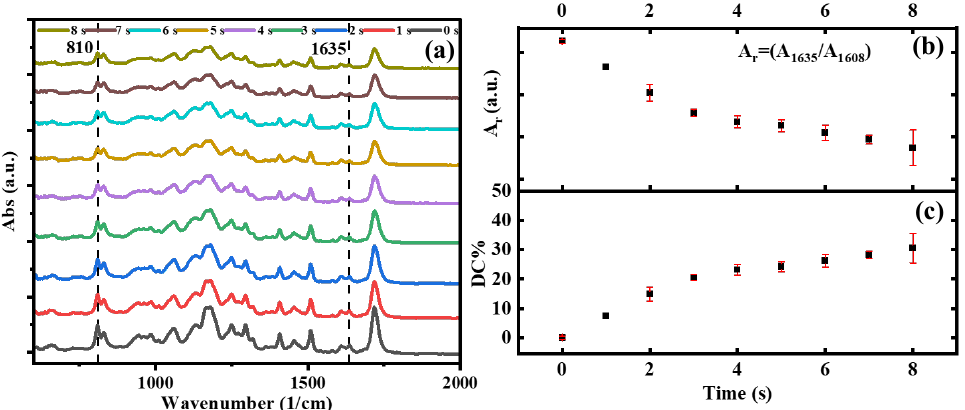
Figure 6. FTIR-ATR absorption spectra of freely polymerized layers and unpolymerized resin ( a ), relative absorbance ( b ), and degree of double bond conversion ( c ) of monolayer films polymerized at different exposure times without printing head configuration.